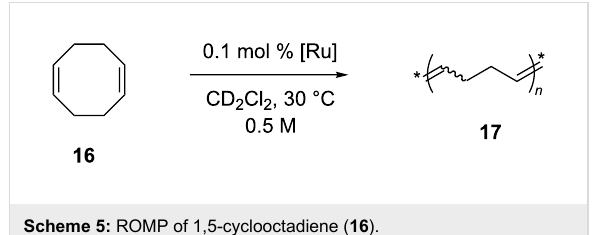
As for the ROMP of 16 (Scheme 5), GII-SIMes and 4a displayed the highest activity with similar